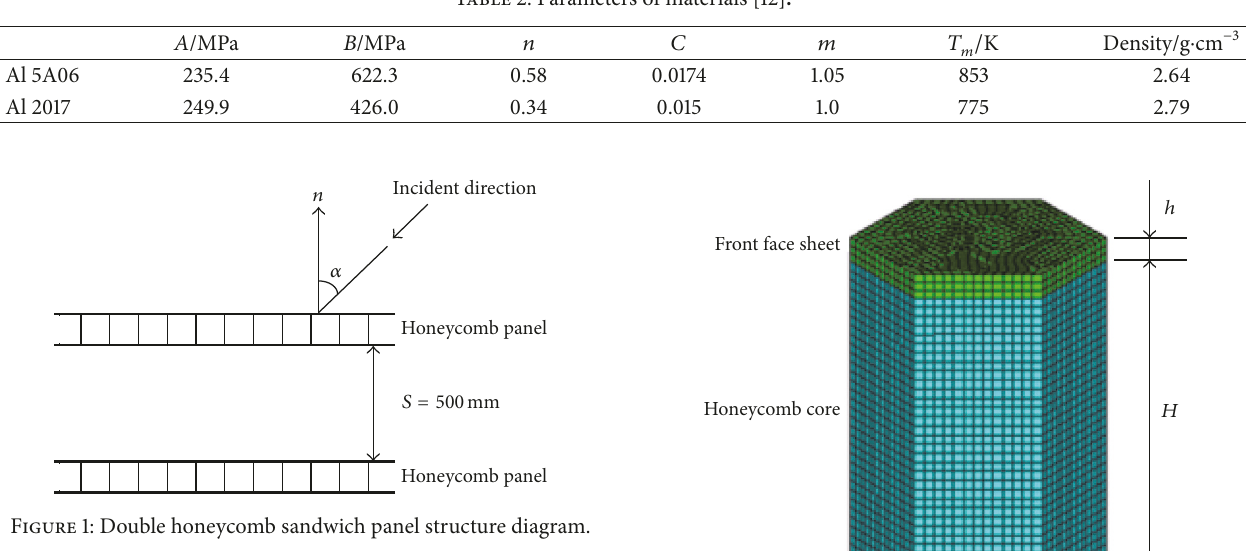
Table 2: Parameters of materials [12] .